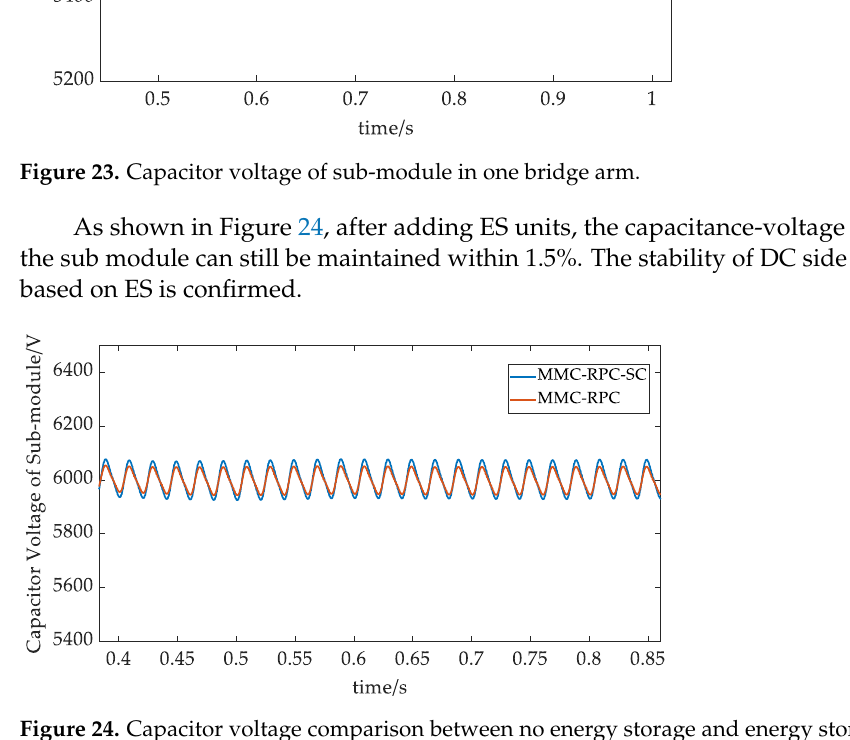
Figure 25. Capacitor voltage of sub module in one bridge arm based on the SC system. As shown in Figure 26, in order to utilize regenerative braking energy, energy ab- sorption is carried out through SCs. SCs under VDCM control reach the desired power in 0.06 s, which confirms the rapidity and stability of the control.